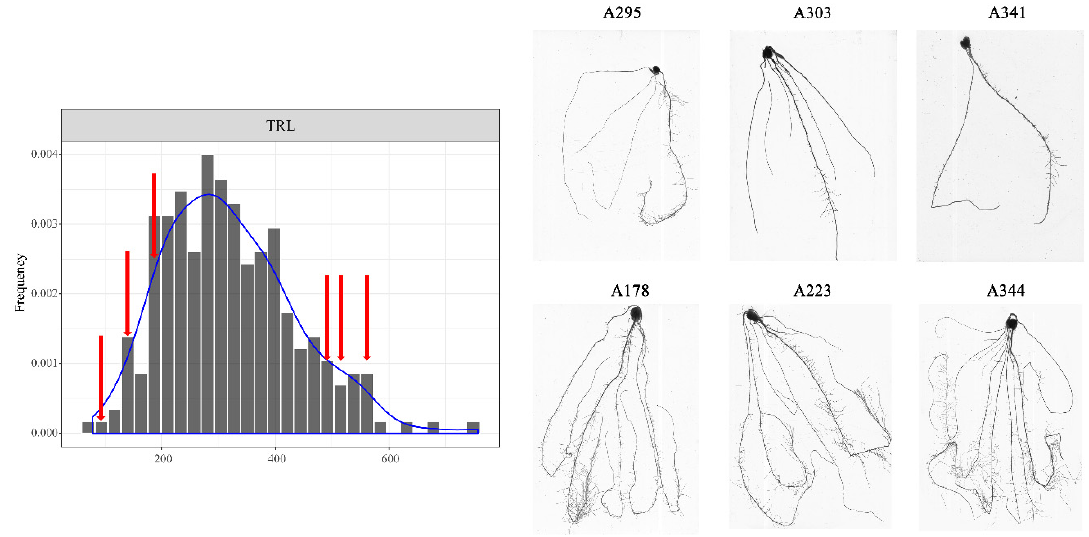
Figure 3. Scanned root images of 3 short-root lines and 3 long-root lines. Table 4. Potential candidate genes identified by GWAS and